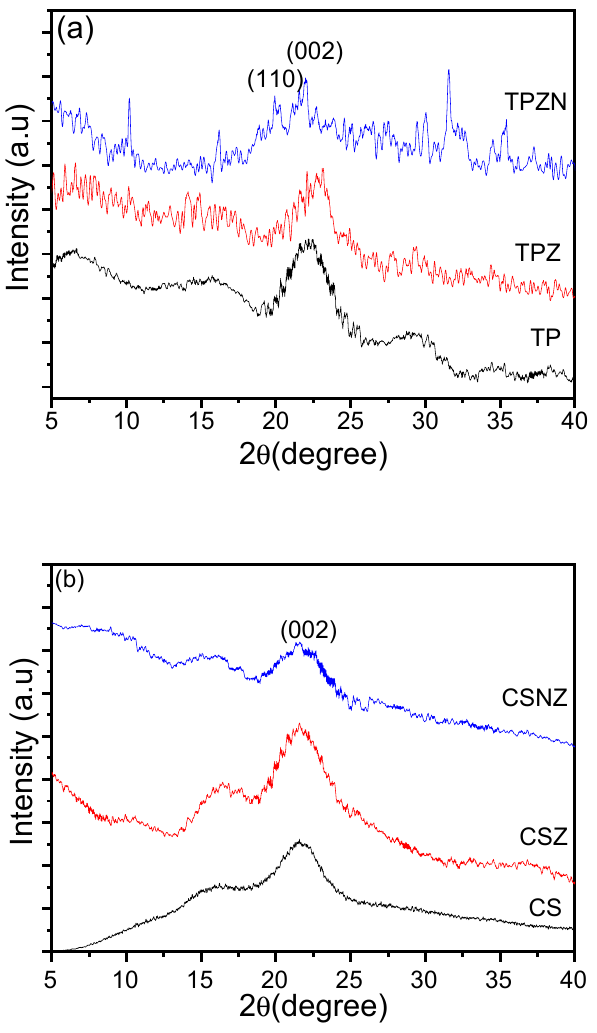
Figure 7. XRD of ( a ) TP and ( b ) CS, before and after pretreatment.